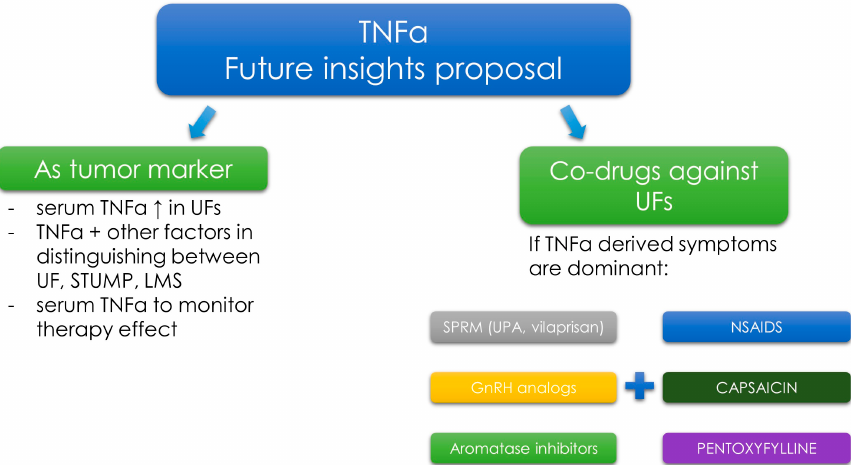
Figure 5. Potential future directions in UF diagnosis and therapy with the use of TNF- α . Tumor necrosis factor α (TNF- α ); uterine fibroid (UF); smooth muscle tumor of uncertain malignant potential (STUMP); leiomyosarcoma (LMS); selective progesterone receptor modulator (SPRM); ulipristal acetate (UPA); nonsteroidal anti-inflammatory drugs (NSAIDS); ↑ as increase.